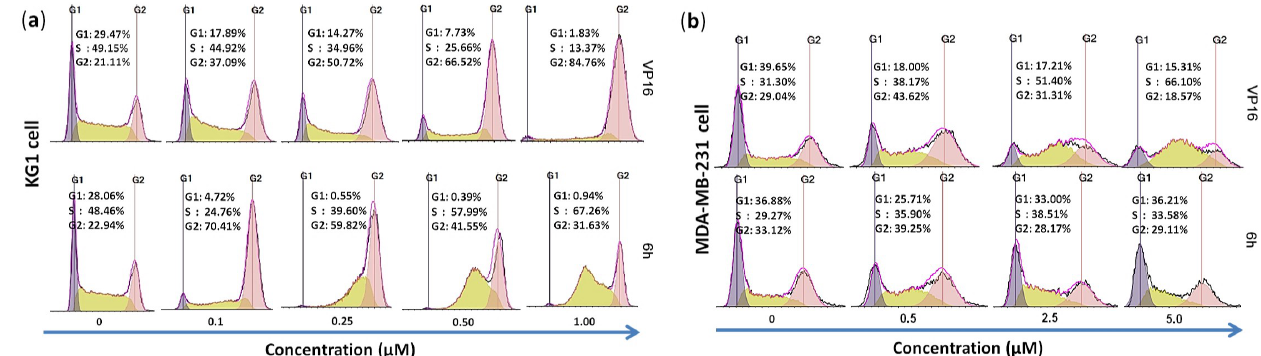
Figure 2. ( a ) Topo II inhibitors 6h and VP16 induced G2/M phase arrest in KG1 cells. Cancer cells were treated with different concentrations of 6h (upper panel) or VP16 (lower panel) for 24 h and subjected to cell cycle analysis. ( b ) VP16 and low concentration of 6h induced S phase arrest in MDA-MB-231 cells while high concentration of 6h gave a different result.